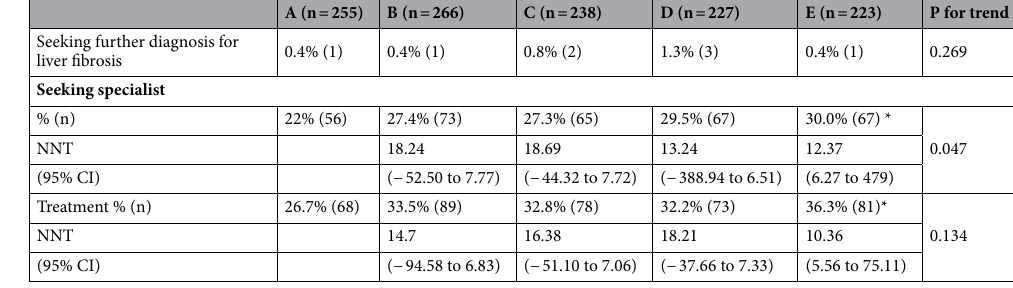
Table 2. Main outcomes. TE transient elastography, NNS NUmber needed to screen. Seeking specialist (gastroenterologist or endocrinologist). Treatment for NAFLD (including nutritional assessment, physical activity, any drug prescribed for NAFLD, or surgical management of obesity). *P-value ≤ 0.05 for group A vs . group E